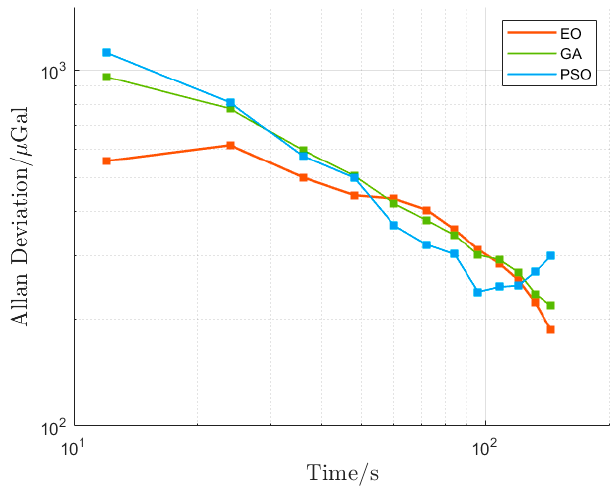
Figure 8. Allan deviation of gravity measurement. Table 3. Comparison of results from 50 vibration compensations.